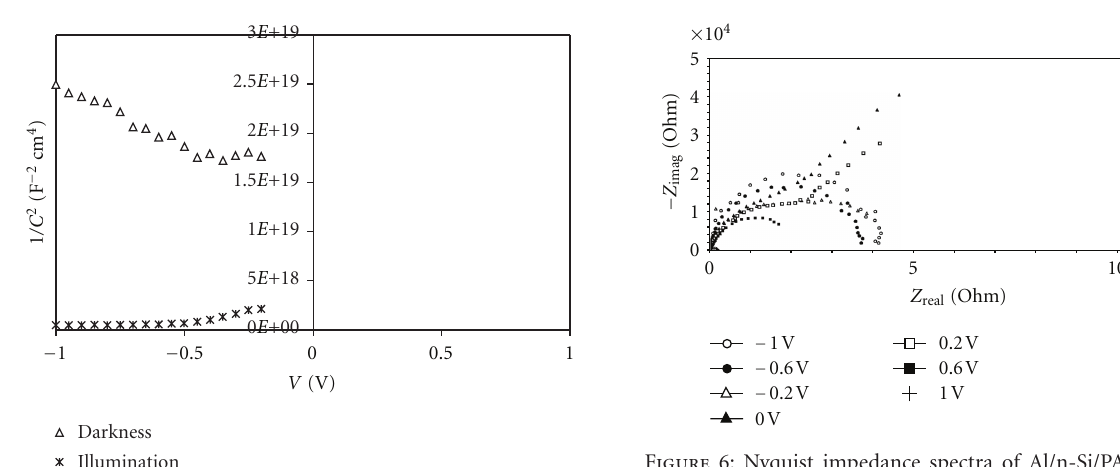
Figure 6: Nyquist impedance spectra of Al/n-Si/PANI-DBSA/Au heterojunctions under darkness at di ff erent